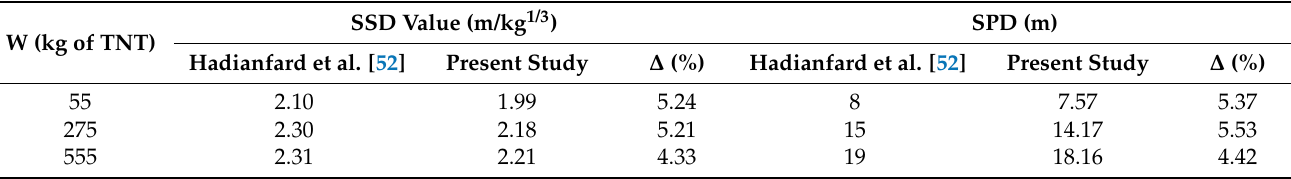
Table 4. Verification results of the proposed formula, with respect to previous study [52].